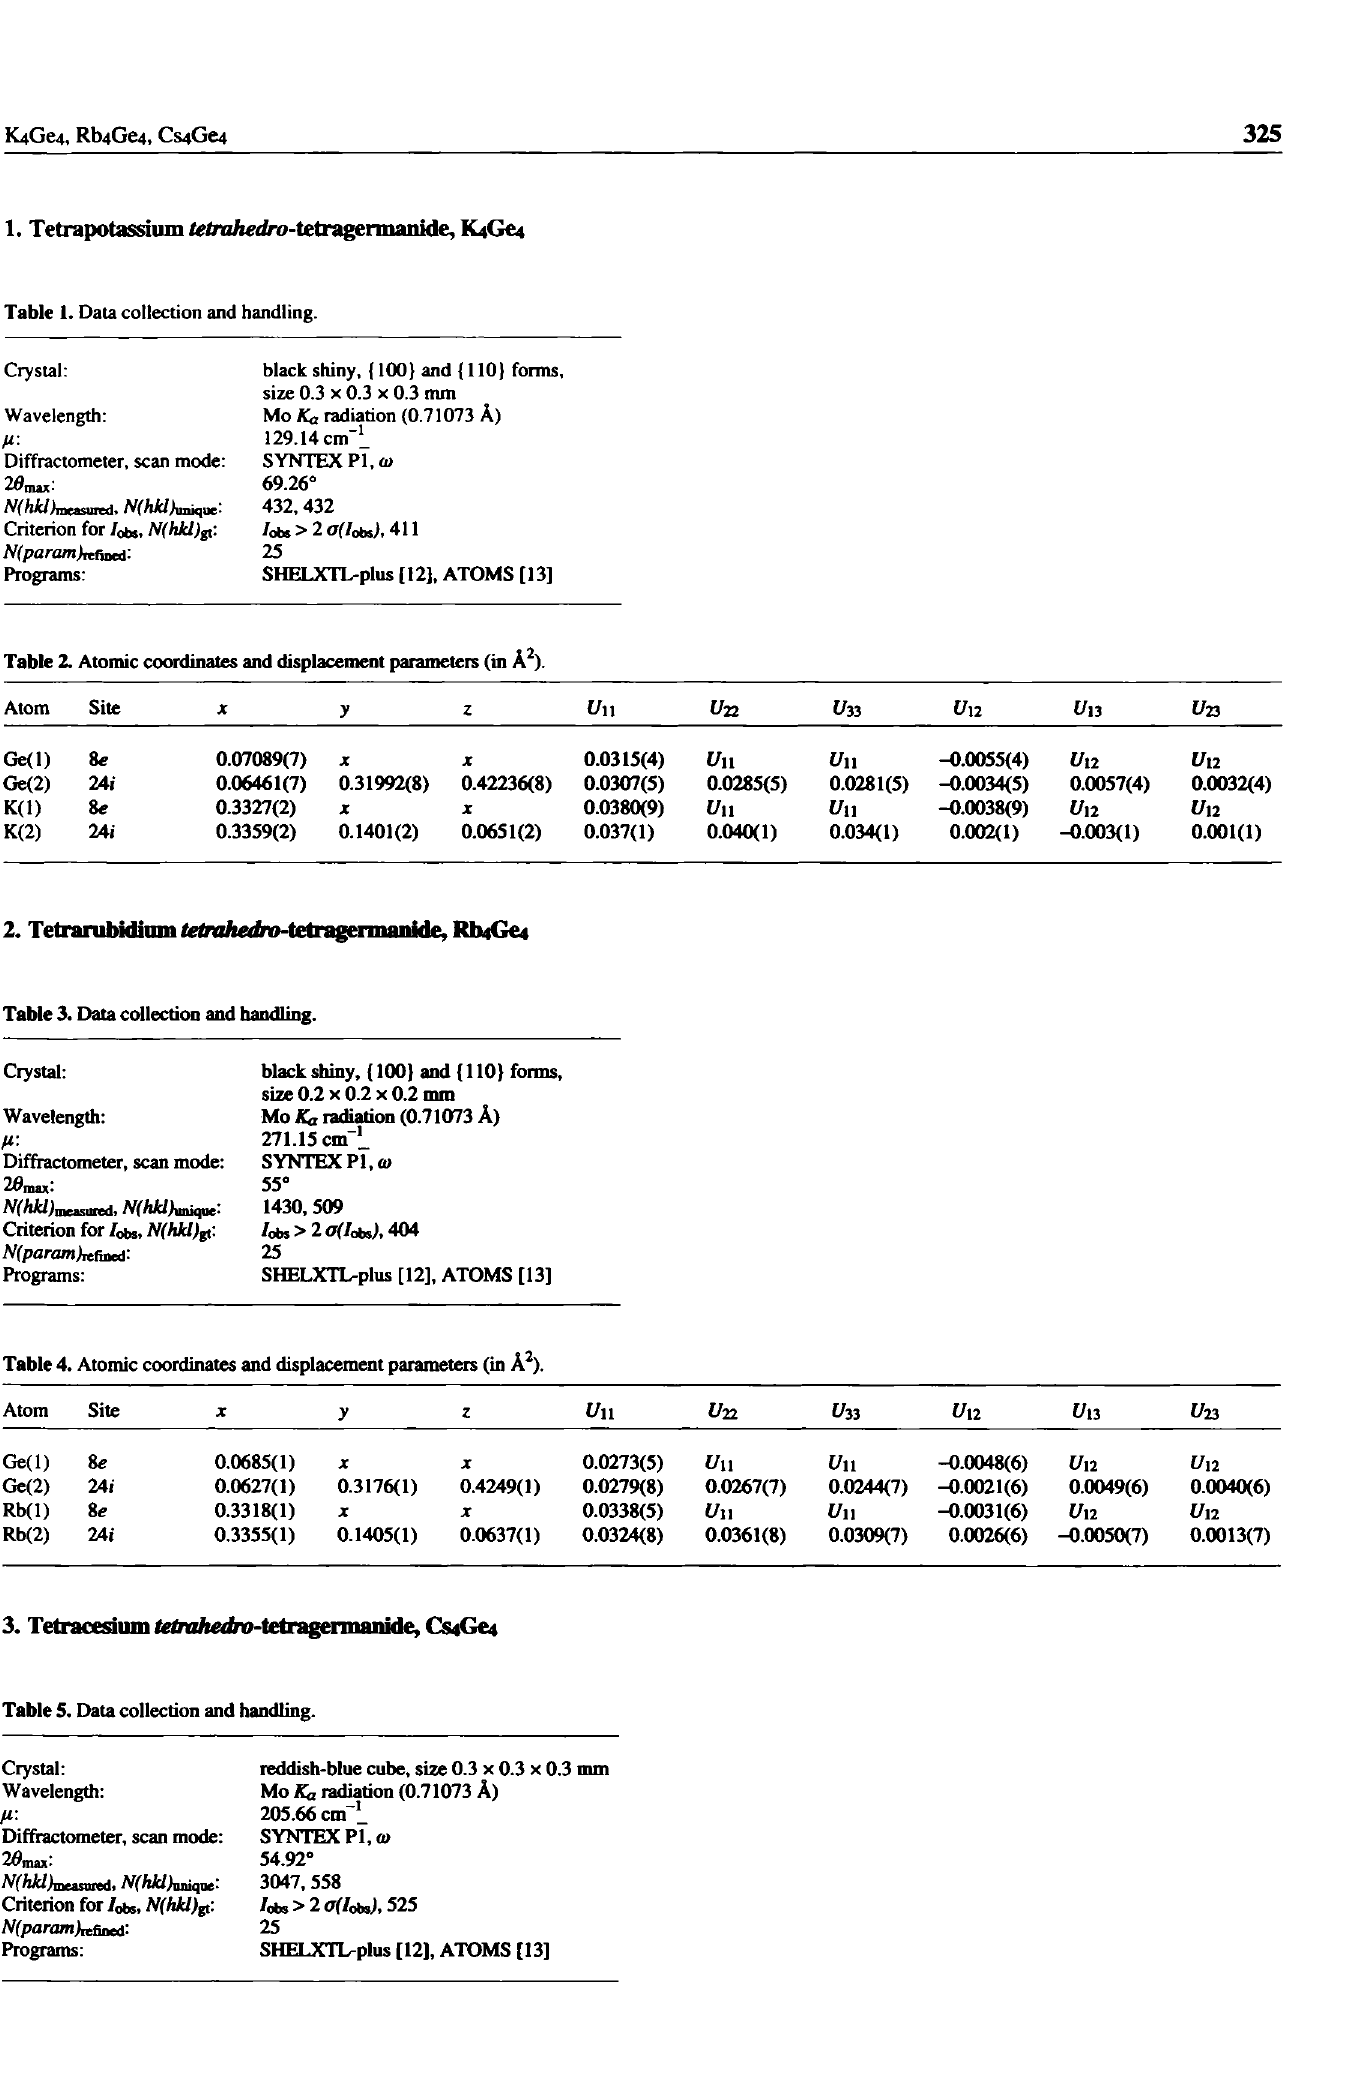
Table 5. Data collection and